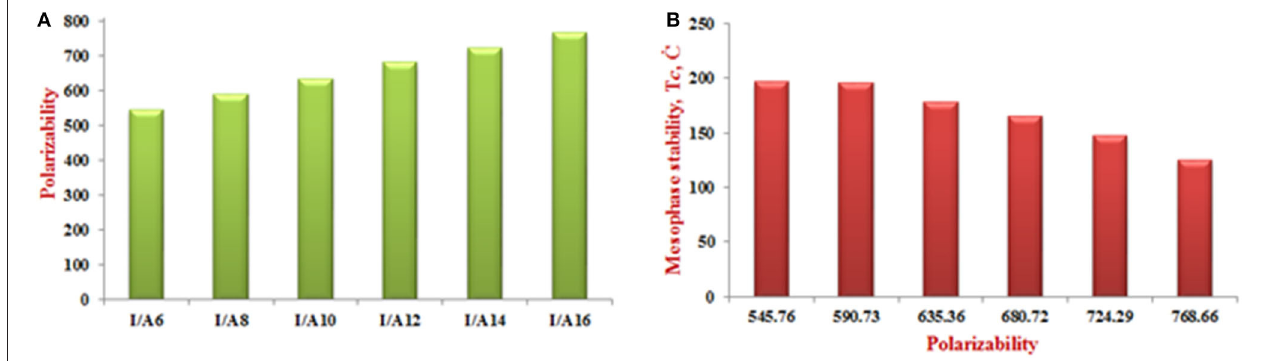
FIGURE 8 | The dependence of the polarizability on the length of the alkoxy chains (A) and (B) transition stability on the polarizability of the complexes I/A n .